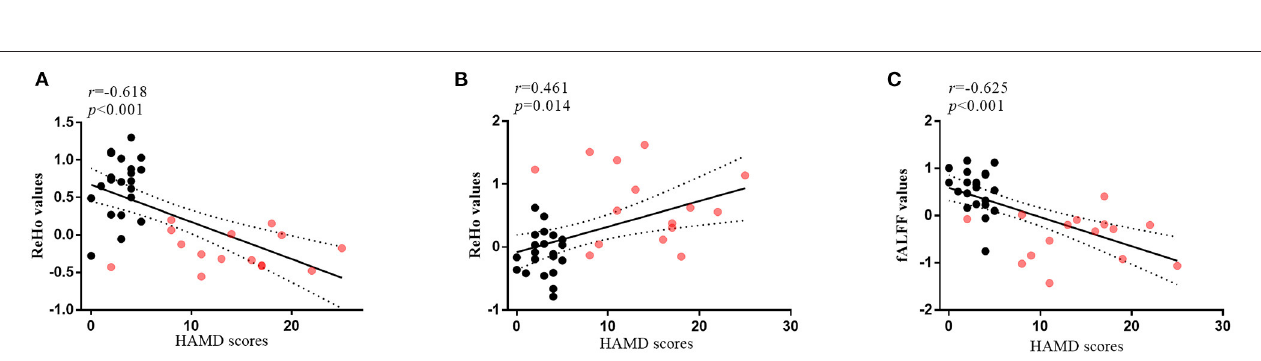
FIGURE 5 | The correlations between altered brain regions and clinical features. (A) The correlation between HAMD scores and ReHo values of the CAL.L ( r = − 0.618, p < 0.001) in all subjects at the baseline; (B) The correlation between HAMD scores and ReHo values of the SFG.L ( r = 0.461, p = 0.014) in all subjects at the baseline; (C) The correlation between HAMD scores and fALFF values of the IPL.L ( r = − 0.625, p < 0.001) in all subjects at the baseline; the red dots, patients with post-stroke depression at the baseline; the black dots, healthy controls; HAMD, 24-item Hamilton Depression Scale; ReHo, regional homogeneity; fALFF, fractional amplitude of low-frequency fluctuation; CAL.L, left calcarine sulcus; SFG.L, left superior frontal gyrus; IPL.L, left inferior parietal cortex.